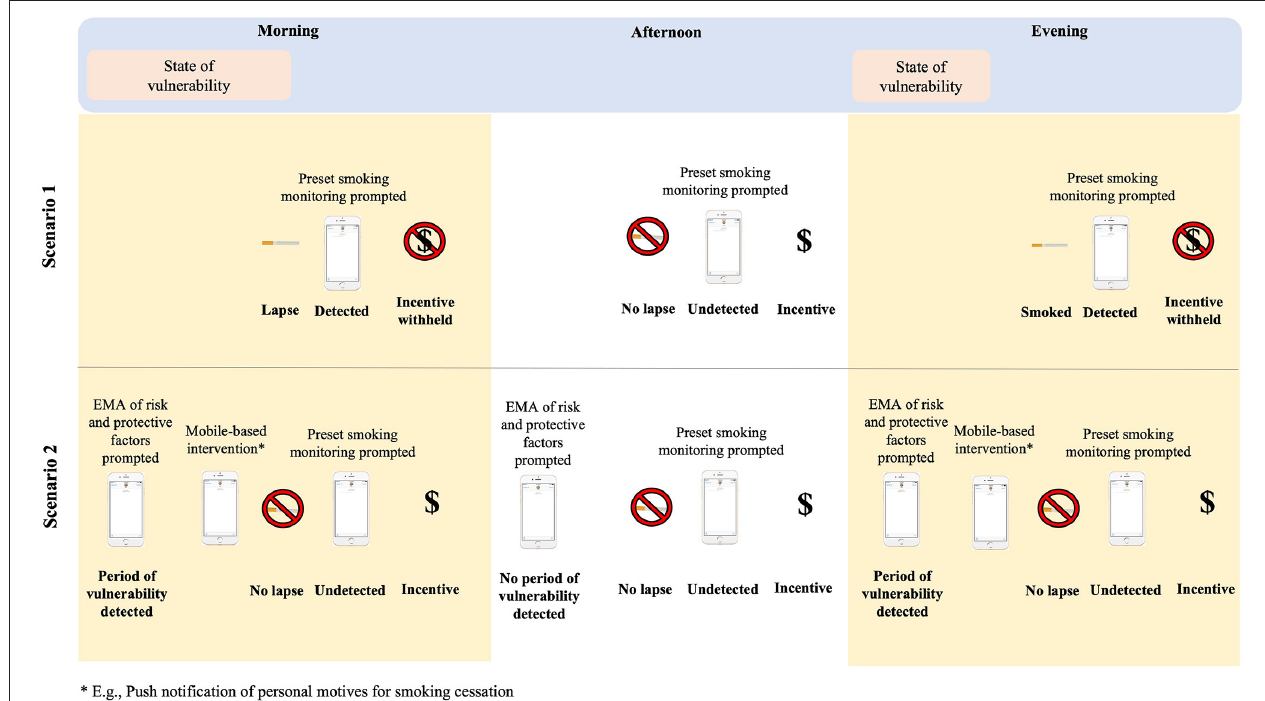
FIGURE 1 | Depiction of conventional digital MIIs (Scenario 1) and a JITAI MII (Scenario 2). EMA, ecological momentary